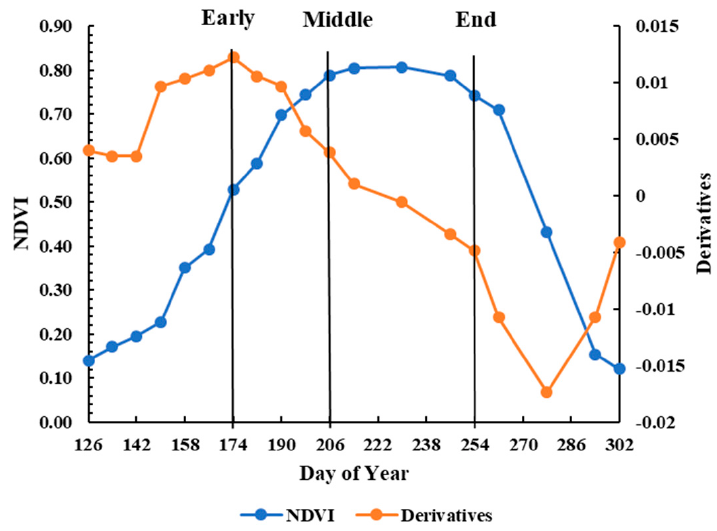
Figure 4. Time-series Landsat NDVI and derivatives curves over the cotton growing season.